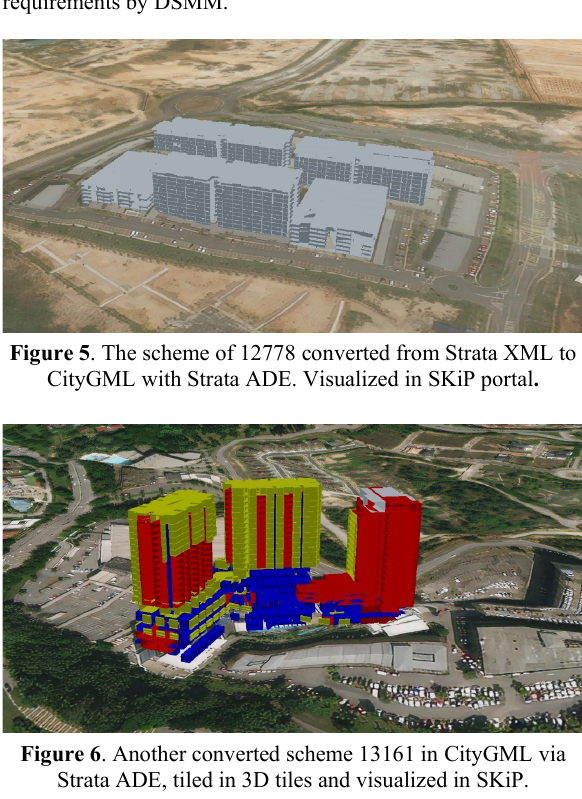
Table 2 . The extension of Strata ADE with CityGML types.